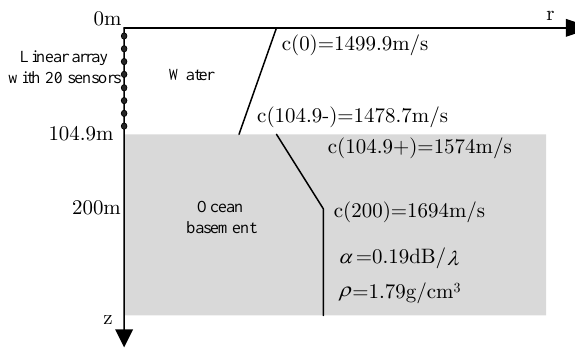
Figure 2. GENLMIS real environment model.